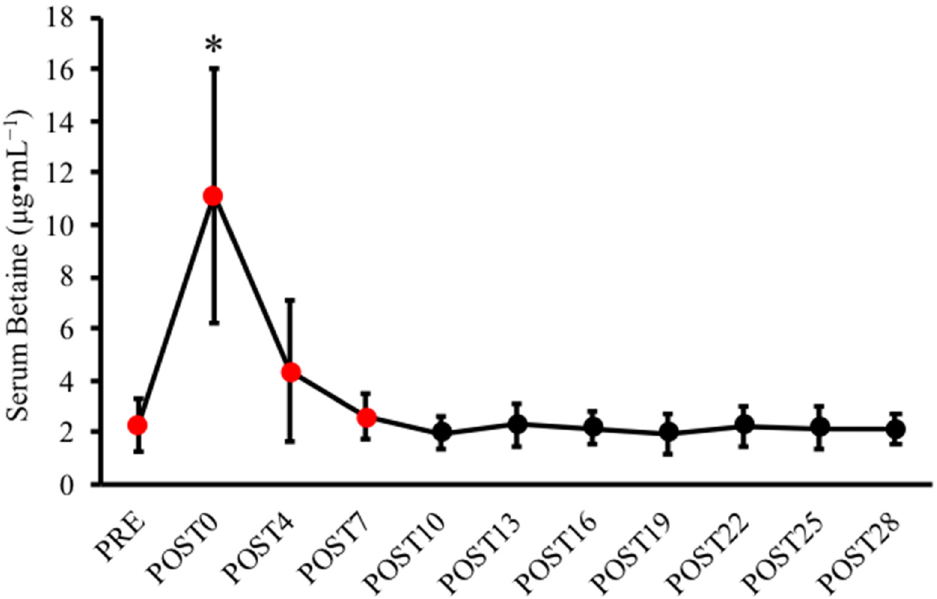
Figure 2. Serum betaine concentrations at baseline and during a 28 day washout period. All data are reported as the means ± SD and performed at a significance level of p < 0.05. * Significant time effect, whereby follow-up analyses (data points analyzed are depicted as red circles) determined a significantly elevated serum betaine at POST0 relative to PRE. Furthermore, neither POST4 nor POST7 concentrations were statistically different from baseline.